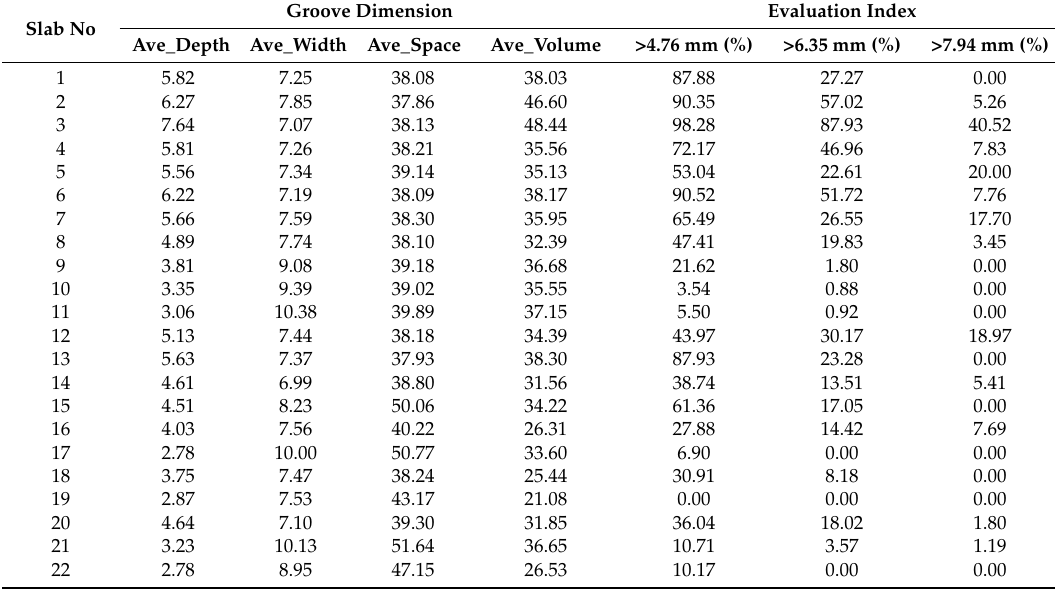
Table 5. Groove Dimension Measurement and Statistic Results with the New